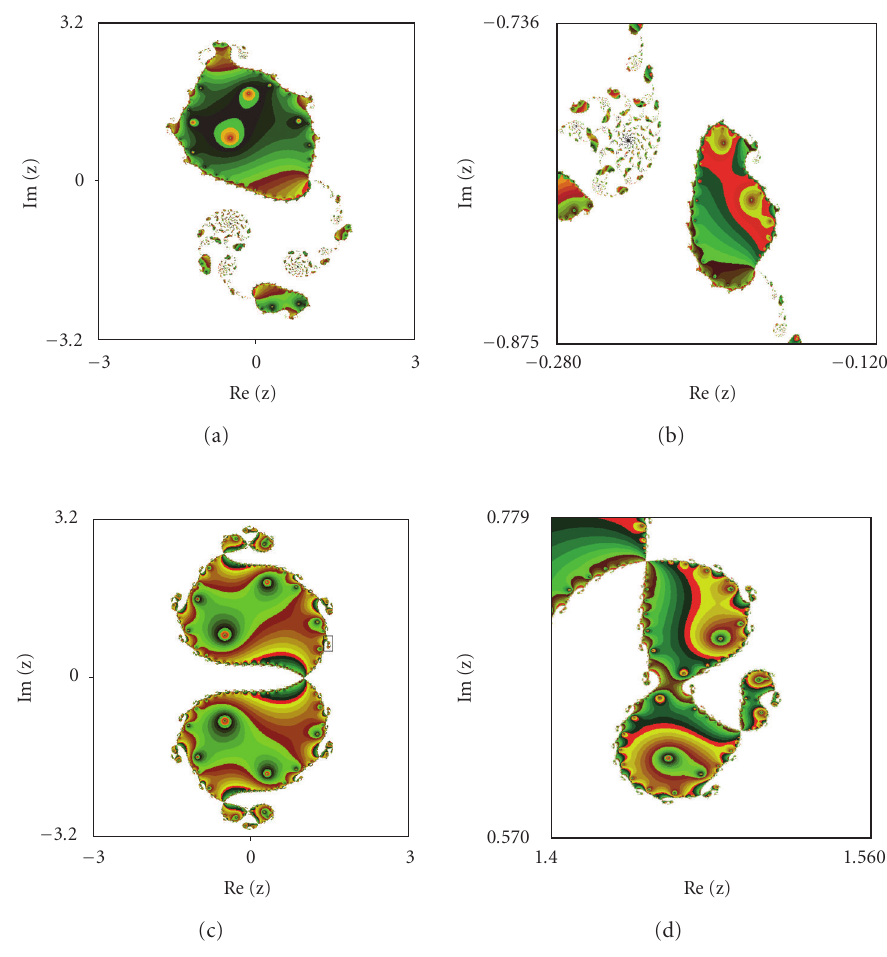
Figure 4.12. Basin of attraction for z 3 − 1 = 0 using GCG method: (a) λ = β = − 0 . 2+ i · 0 . 1, (b) en- largement of the part framed in (a), (c) λ = β = − 0 . 2, (d) enlargement of the part framed in